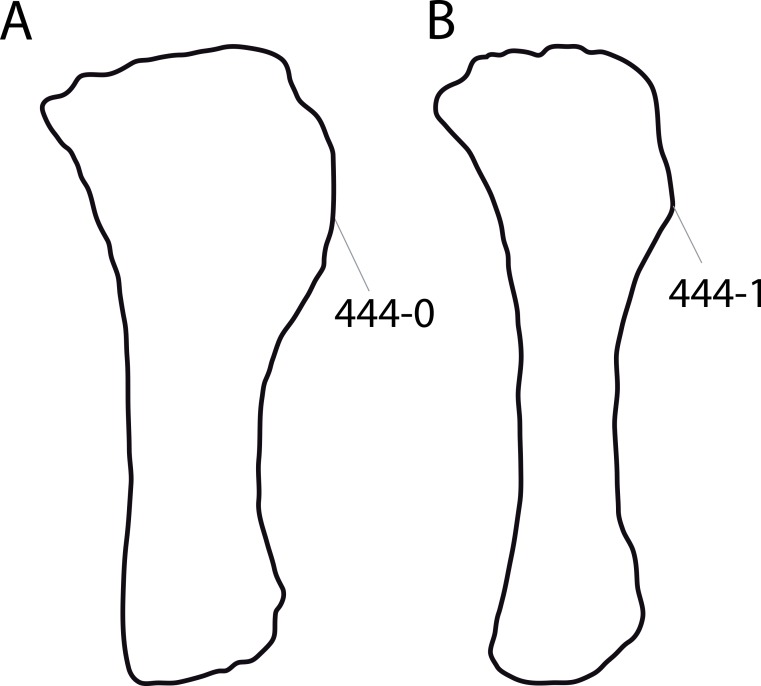
Diplodocoid tibiae.Tibia of Zapalasaurus sp. MOZ-Pv 1244 (A; traced from Salgado et al., 2012) and Tornieria africana MB.R.2572 (B; traced from Remes, 2006) in anterolateral view, illustrating the different shapes of the cnemial crest (widely rounded, A, C444-0; triangular, B, C444-1). Scaled to same length.